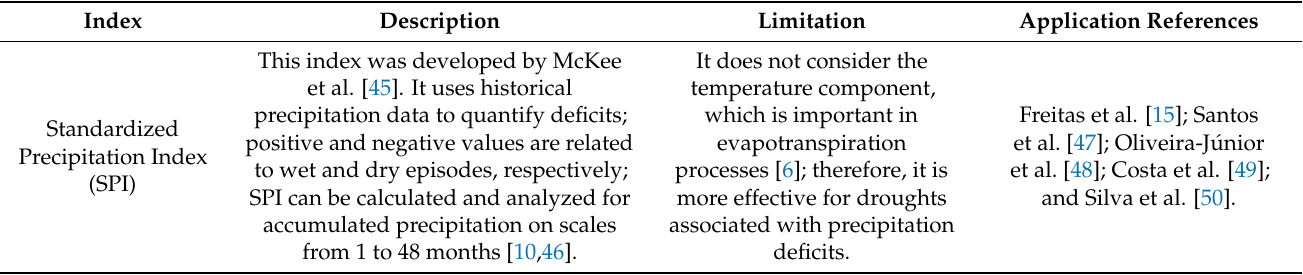
Table 1. Summary of the main indices applied to identify droughts in Brazil. A brief description, its limitations, and some work with applications are provided for each